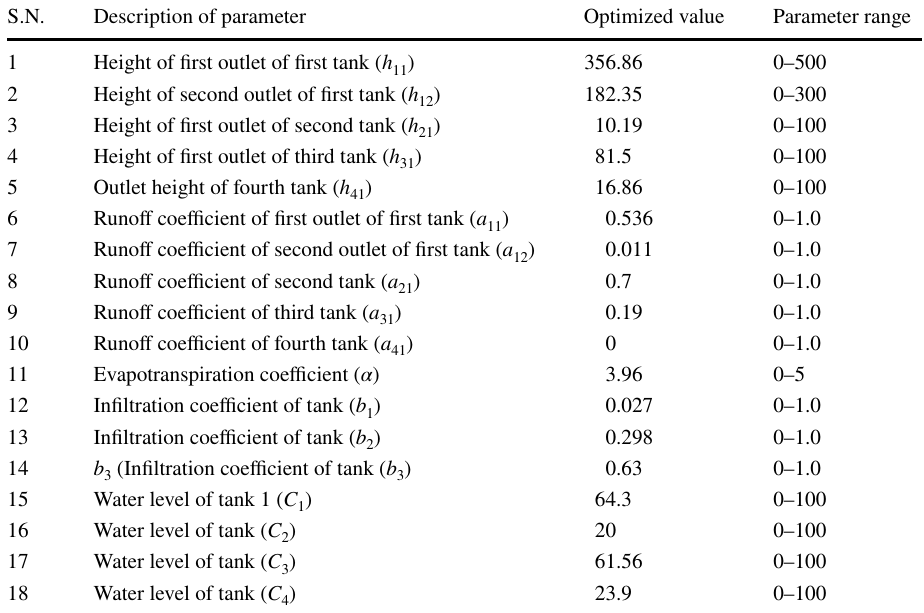
Table 4 Calibrated value and range of parameters of TANK